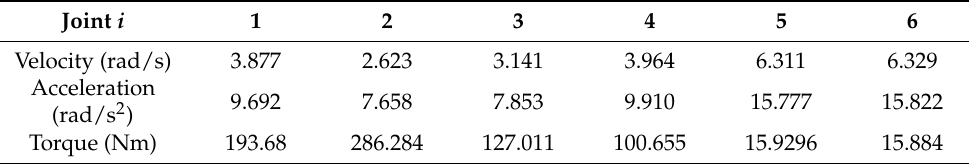
Table 2. Absolute value limits of joint angles, velocities and